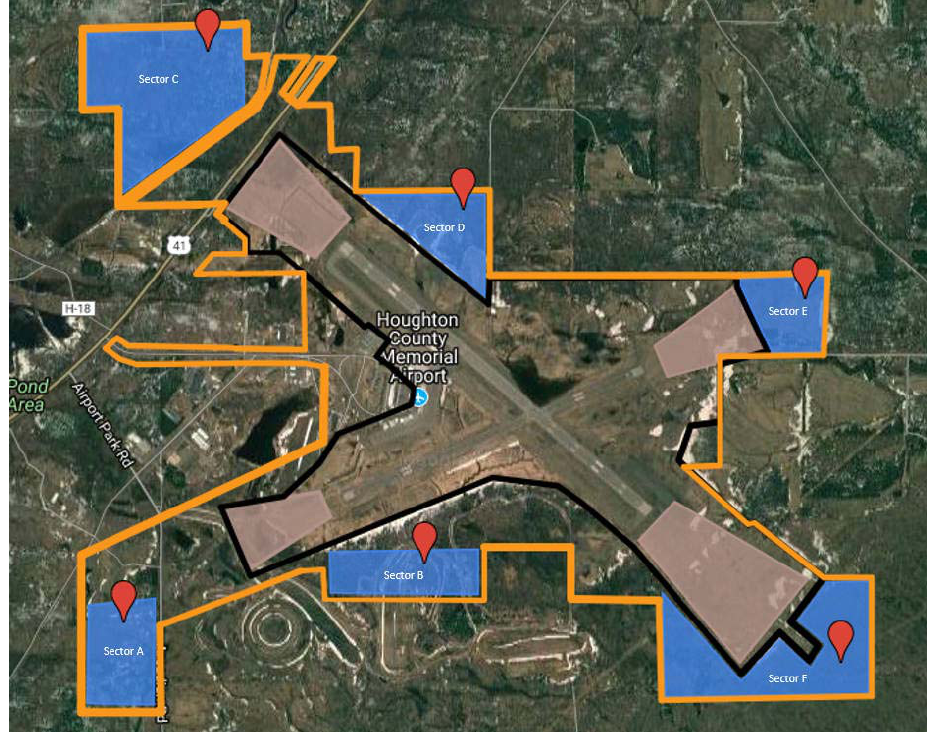
Figure 3. Ariel view of Houghton County Memorial Airport (CMX) airport, with the PV deployment zones marked. Note: The four pink trapezoid zones are the restricted areas showed in Figure 1; black lines enclosed clean area, and no objects other than necessary terminal buildings are allowed in this zone; the orange line enclosed the area which is total airport land property, and; the six red pins are suggested land/sites for the deployment of solar PV systems.